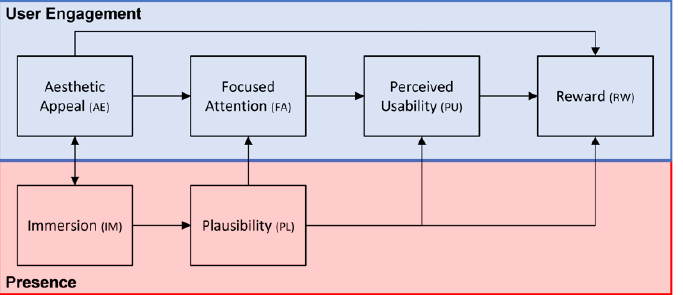
Figure 5. User engagement with immersive tools: the proposed interplay between user engagement and presence.